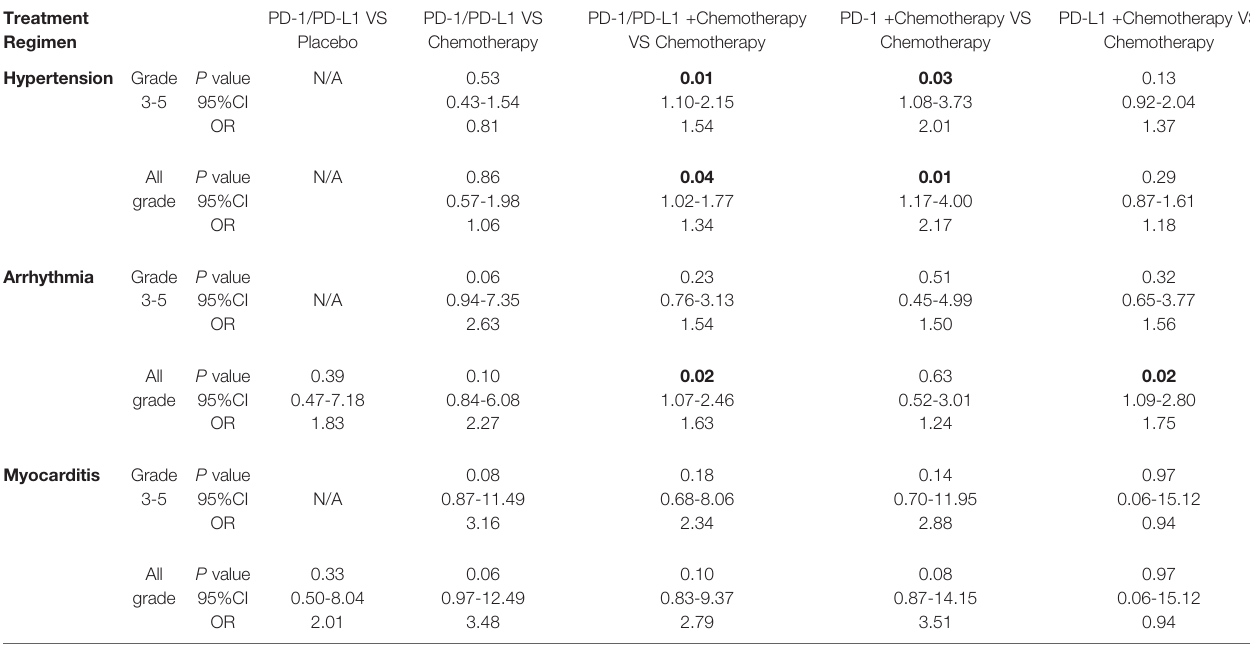
TABLE 3 | The risk of all-grade and grade 3-5 myocarditis, arrhythmia and hypertension. Treatment